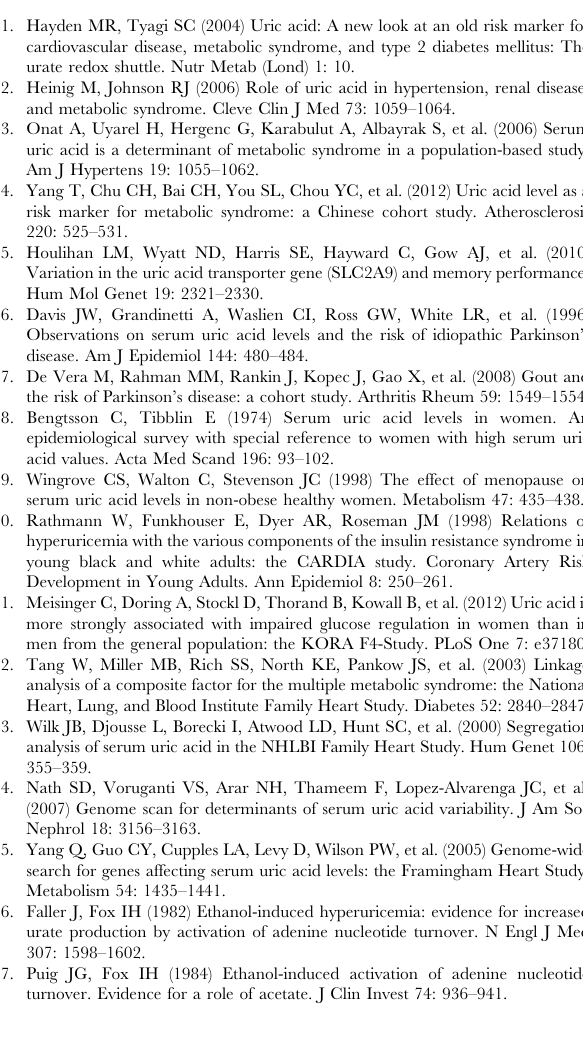
Table S2 The final multiple linear regression model (Model 1) and the alternative model, with MS predictors replaced by graded MS (Model 2). * log-transformed for the model, coefficient and standard error relevant for the transformed variable. ** values for man/woman because of an interaction with gender present in the